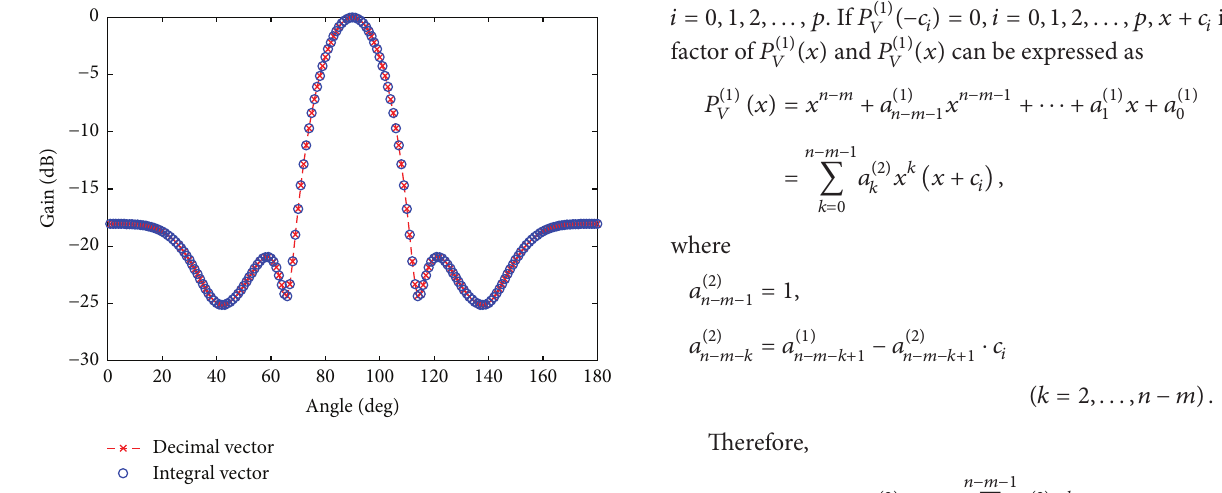
Figure 2: Performance of decimal vector and integral